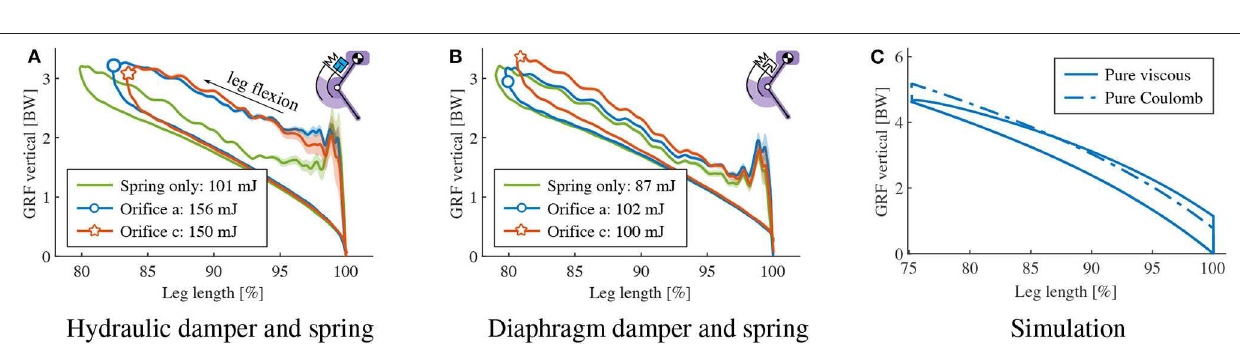
We propose a method to indirectly calculate the contribution of viscous damping, by measuring and eliminating effects from Coulomb friction, and unsprung